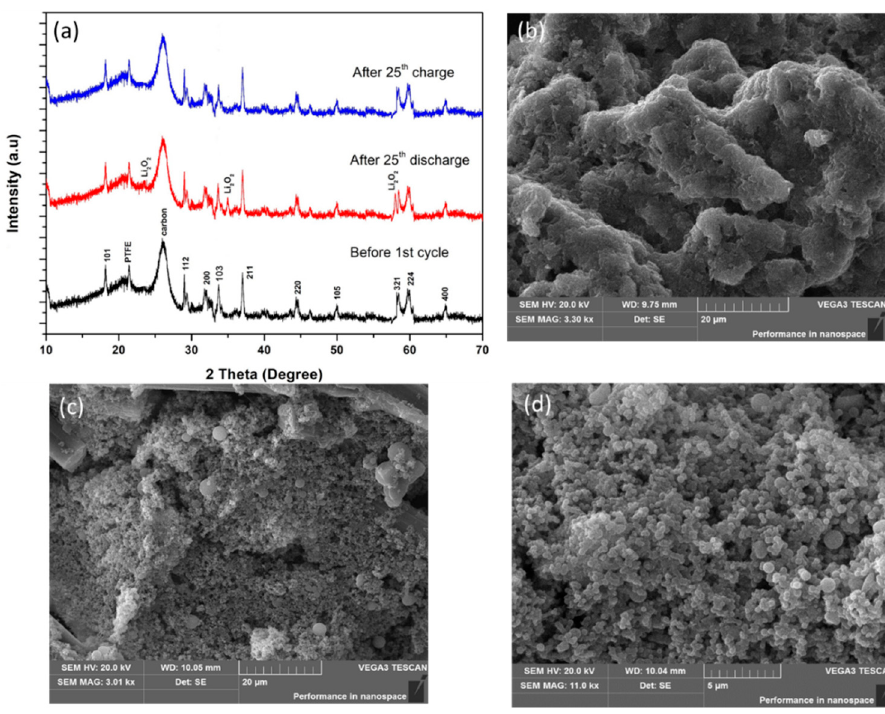
Figure 6. ( a ) The XRD patterns of the MOHNs/KB cathode before the cycle, after the 25th discharge cycle, and after the 25th recharge cycle; ( b ) the SEM image of the MOHNs/KB cathode after the 25th discharge; ( c , d ) the SEM image of the MOHNs/KB cathode after the 25th recharge.